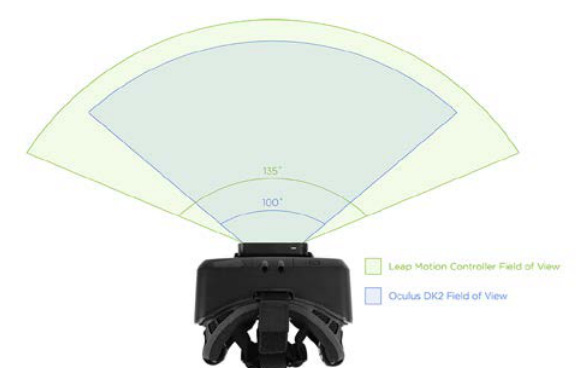
Figure 5. The comparison between Oculus and Leap Motion filed of view